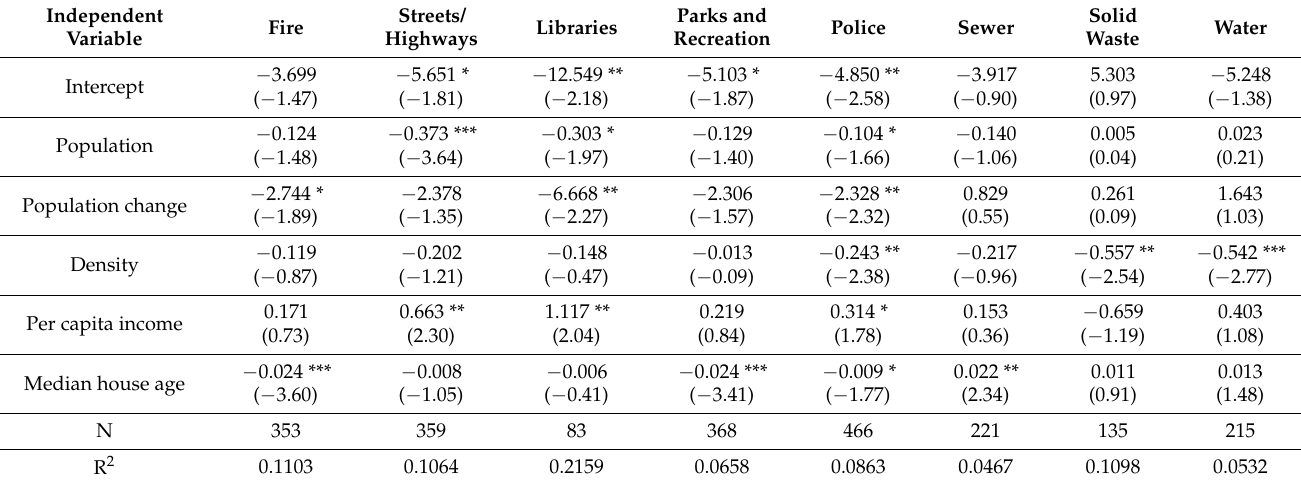
Table 5. Results for models of per capita municipal expenditures, land and existing facilities costs. Independent Variable